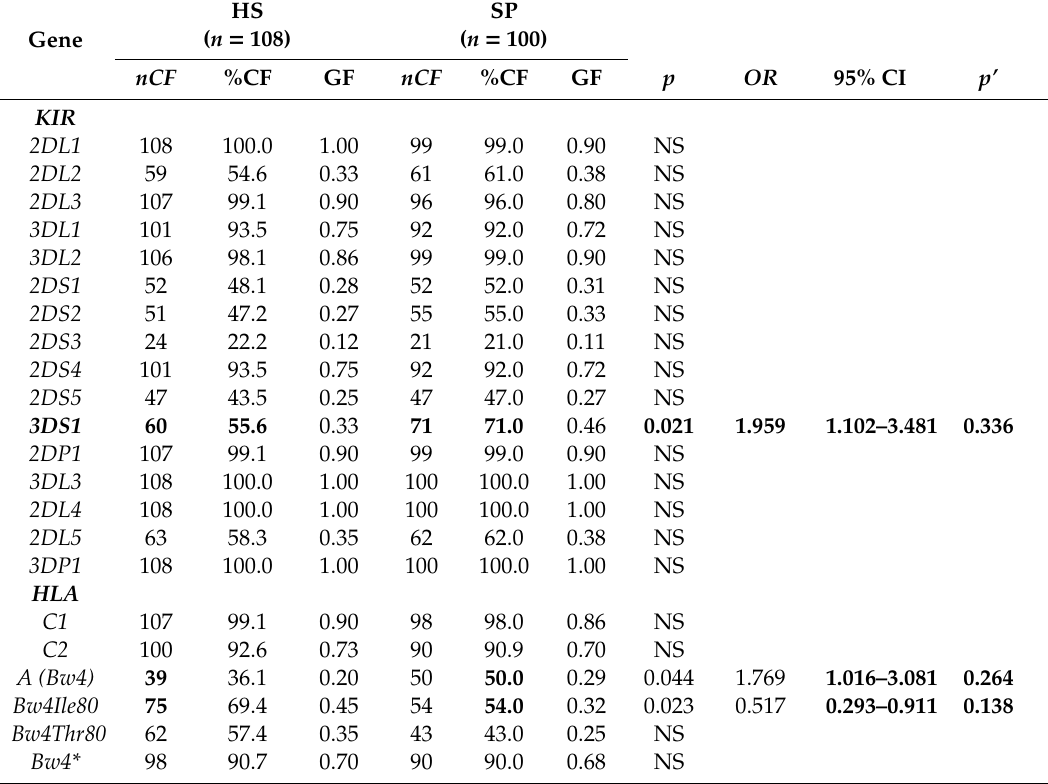
Table 1. Distribution of KIR and HLA genes in healthy subjects and subjects with psoriasis